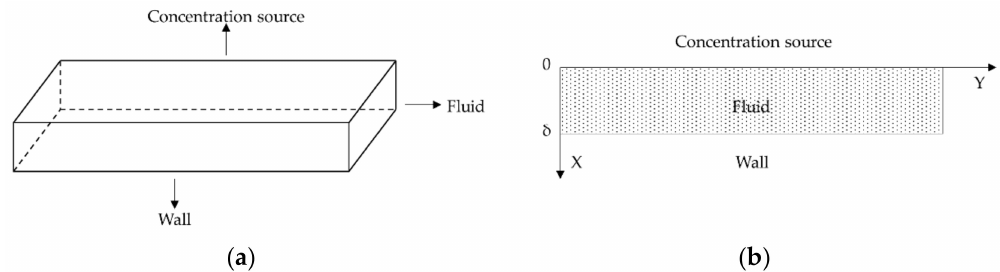
Figure 1. Convective diffusion model of microfluidic chip for drug delivery: ( a ) The simplified convective diffusion model; ( b ) The rectangular coordinate system of the section of convective diffusion